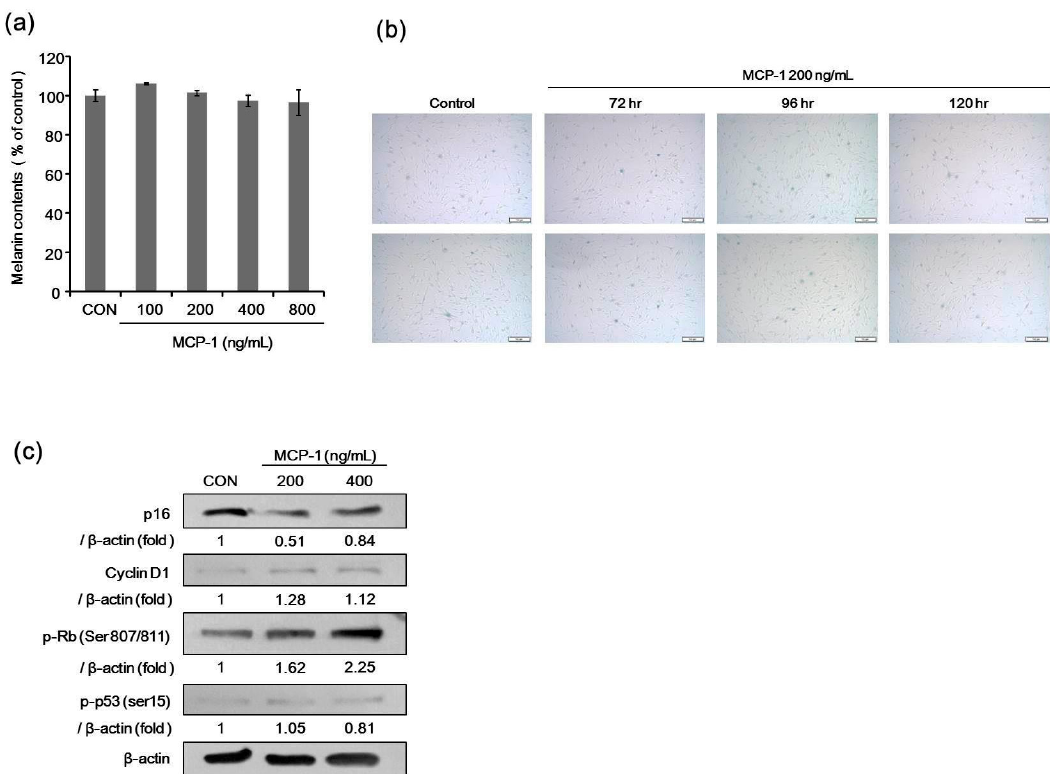
Figure 6. ( a ) Effects of MCP-1 on melanogenesis. Melanin content was measured in NHMs after 120 h of treatment with 100–800 ng/mL MCP-1. Data are the mean ± standard deviation (SD) of triplicate assays and are expressed as a percentage of the control; ( b ) the effects of MCP-1 on NHM senescence were evaluated by SA- β -Gal staining. Cells were seeded at the same density in 6-well plates and were stained for SA- β -Gal using a commercial histochemical staining kit (scale bar: 50 µm); ( c ) proliferation-associated proteins in NHMs were determined after treatment with 200 or 400 ng/mL MCP-1 for 72 h. β -actin expression was detected as the loading control.